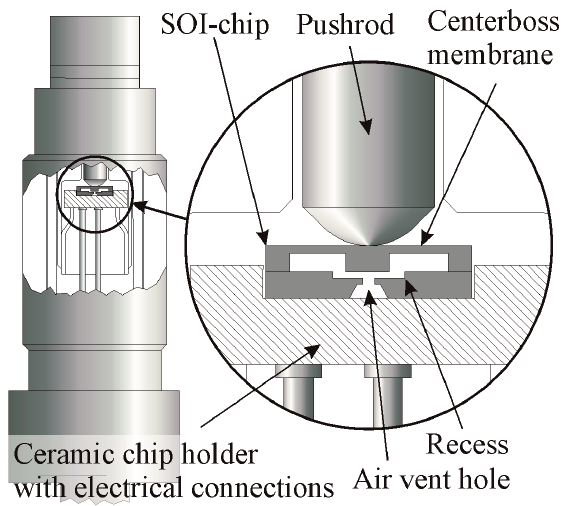
Figure 1. Schematic view on a fully packaged pressure sensor using floating concept, ( left ) with enlarged cross section of the packaged SOI-chip